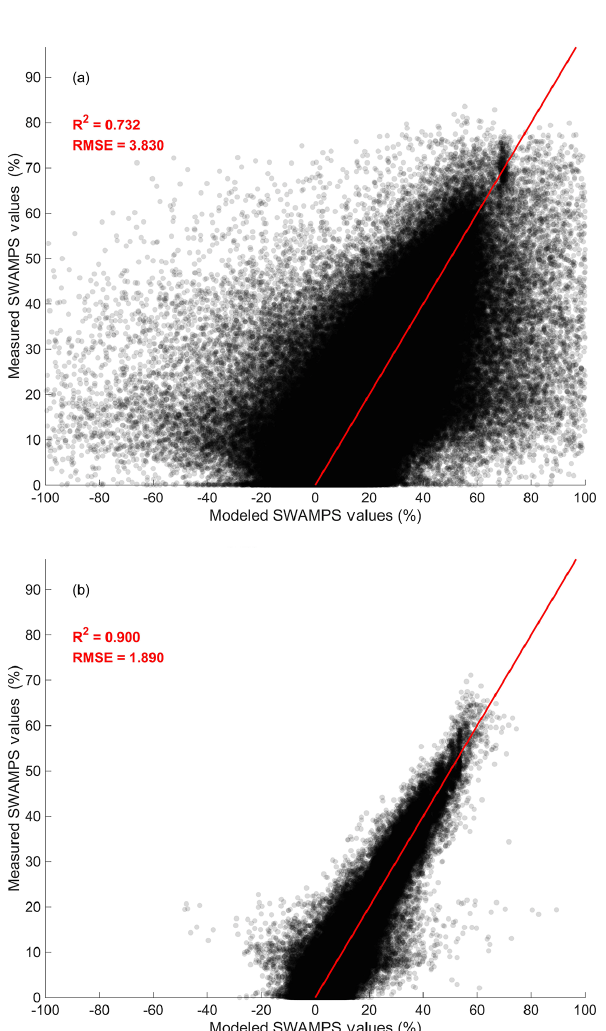
Figure 6. Visual comparison of monthly modeled and measured SWAMPS data. (a) Modeled surface inundation. (b) Measured sur- face inundation. (c) The absolute difference between modeled and measured surface inundation. Modeled SWAMPS data have a time lag correction of 0 to 5